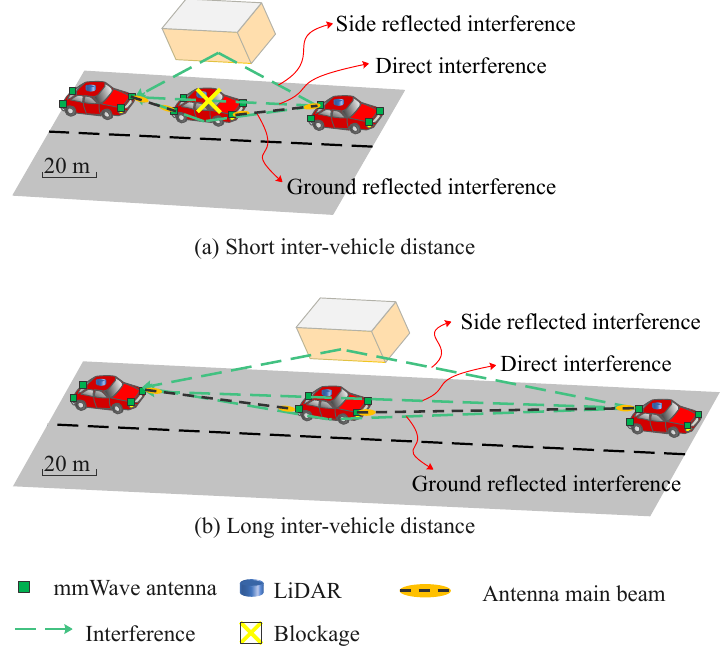
Figure 5. Diagram of ZigZag antenna configuration in short and long inter-vehicle distance